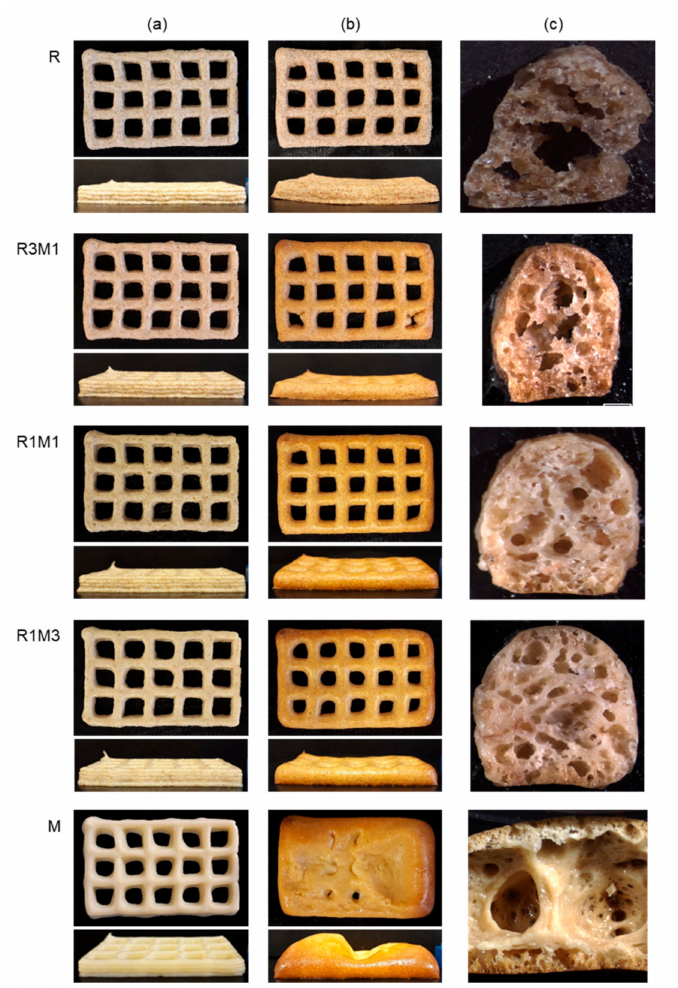
Figure 7. Appearance of 5-layer samples after printing ( a ) and baking ( b ). Stereomicroscopic images of sample cross-sections are presented in panel ( c